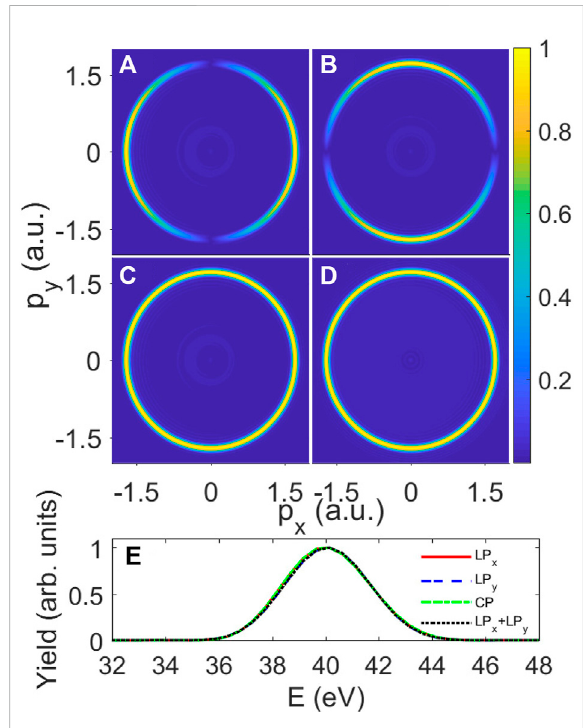
circular pulses, when either E 0 x or E 0 y vanishes, we obtain linear pulses. The pulse pro fi le f ( t ) is the sine-squared pro fi le, and ω is the central frequency of the laser pulse.